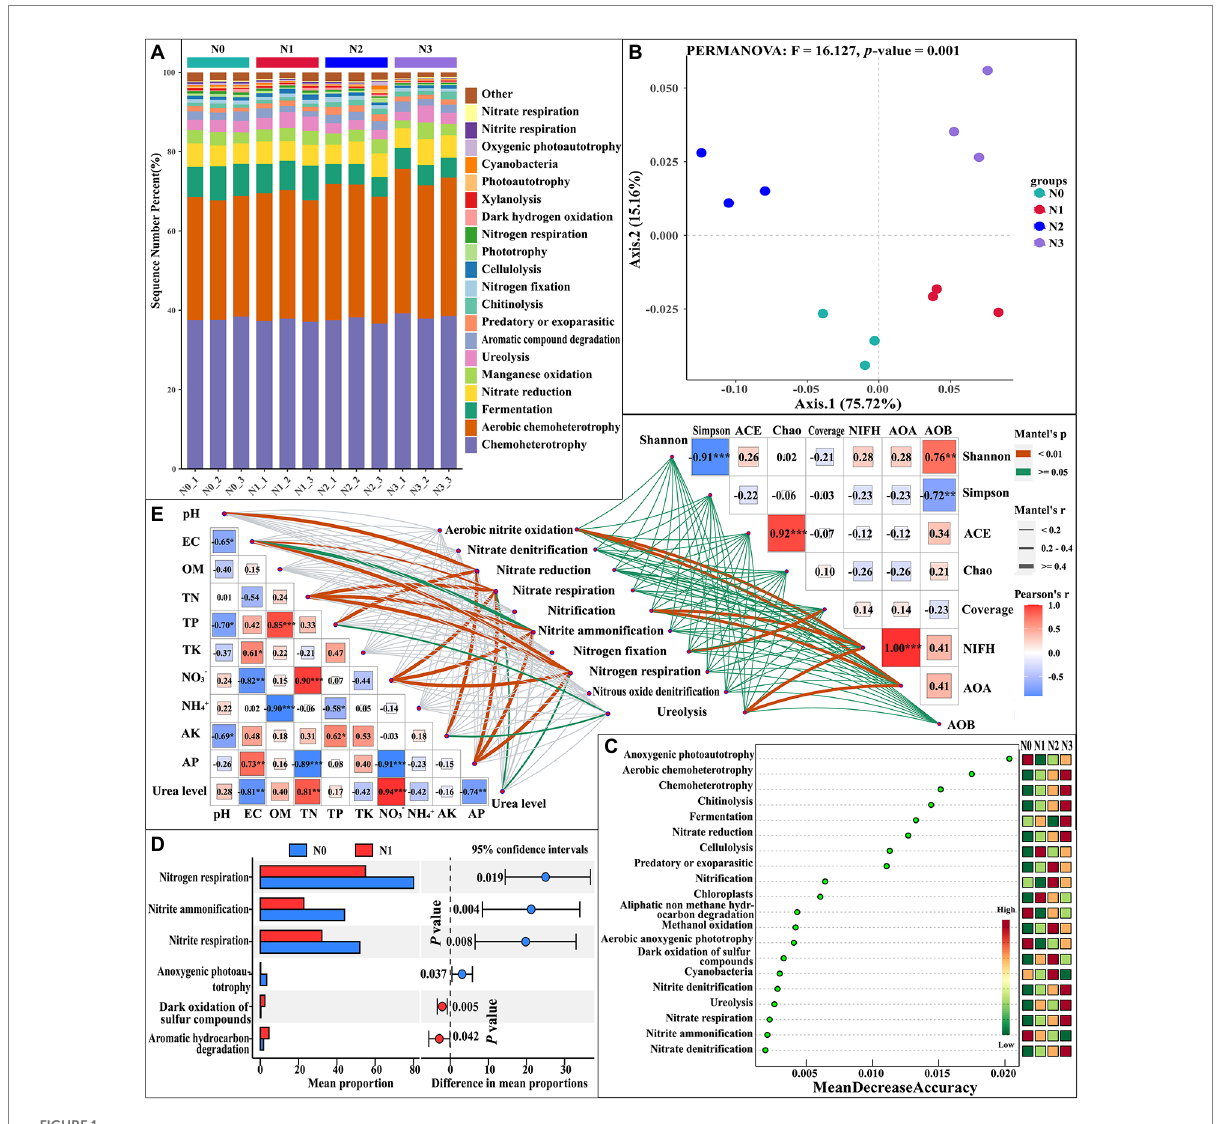
FIGURE 1 Influences of experimental N addition on microbial function and nitrogen metabolism